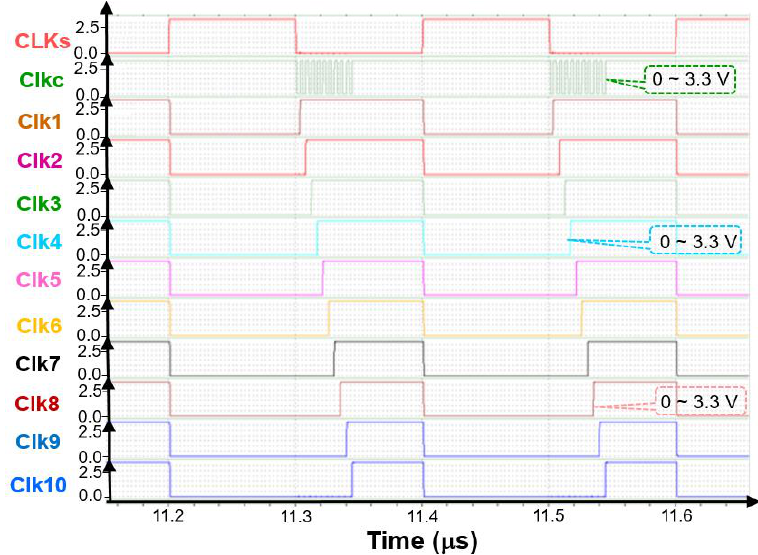
Figure 18. Simulated propagation delays at five process corners with common-mode voltage of 100 mV.